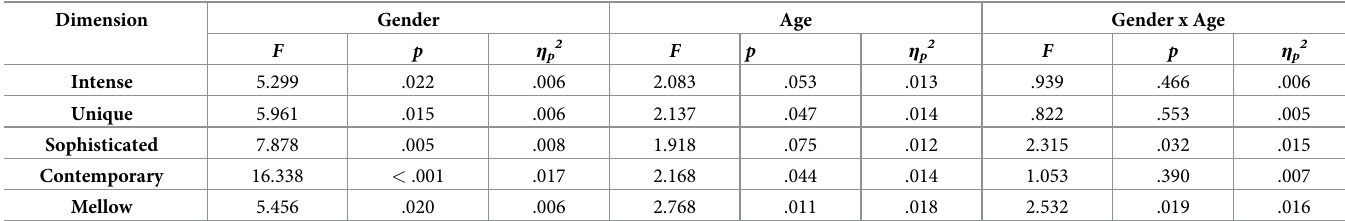
Table 4. ANOVA and effect sizes ( η p2 ) for musical styles by gender and age.